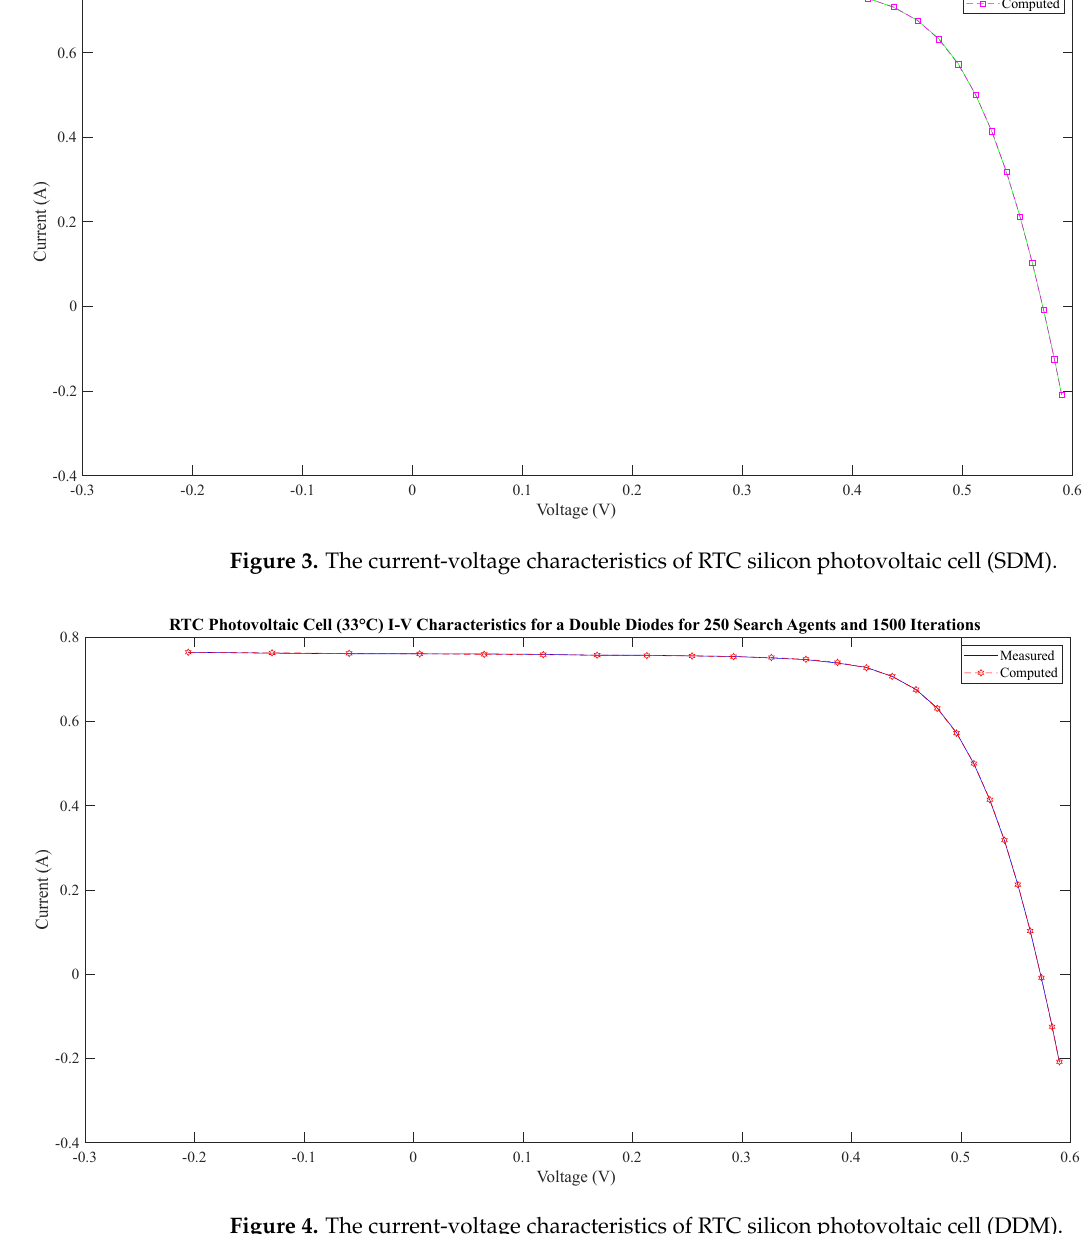
Figure 4. The current-voltage characteristics of RTC silicon photovoltaic cell (DDM).